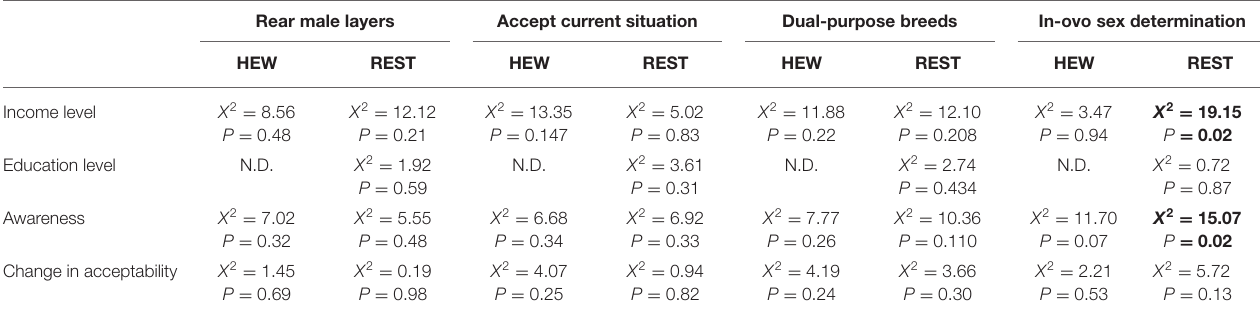
Table 4 | Chi-square test-statistics representing effects of income levels, education level, awareness levels and change in acceptance of culling day-old male layer chicks on alternatives for this